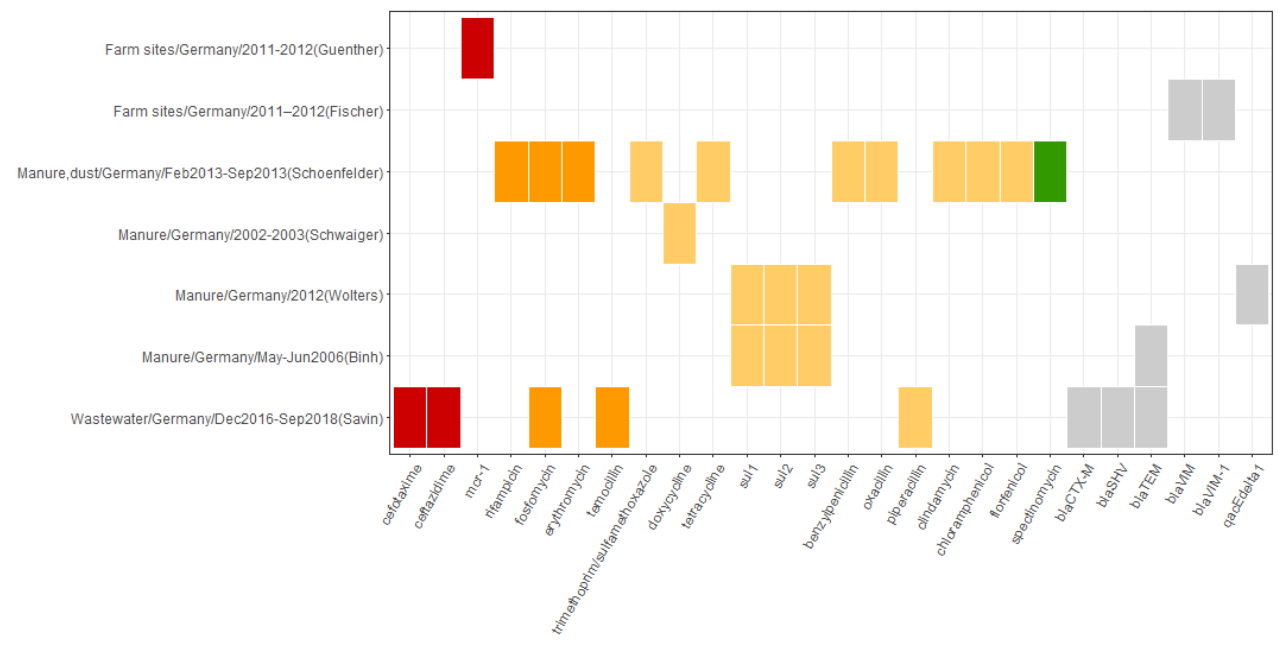
Figure 5. Overview of the occurrence of reported antibiotic resistance patterns in the environment of animal husbandry. The horizontal axis depicts resistance patterns as reported in the primary studies and includes antibiotic compounds, antibiotic classes, resistance mechanisms, and ARGs. The vertical axis represents the source of resistance associated with resistance patterns depicted on the horizontal axis as follows: source of sample/Country of study/Sampling period/(First author of the reporting study). The color profile represents the WHO CIA list categories: red, Critically important: Highest Priority; orange, Critically important: High Priority; yellow, Highly important; green, Important; grey, not listed.